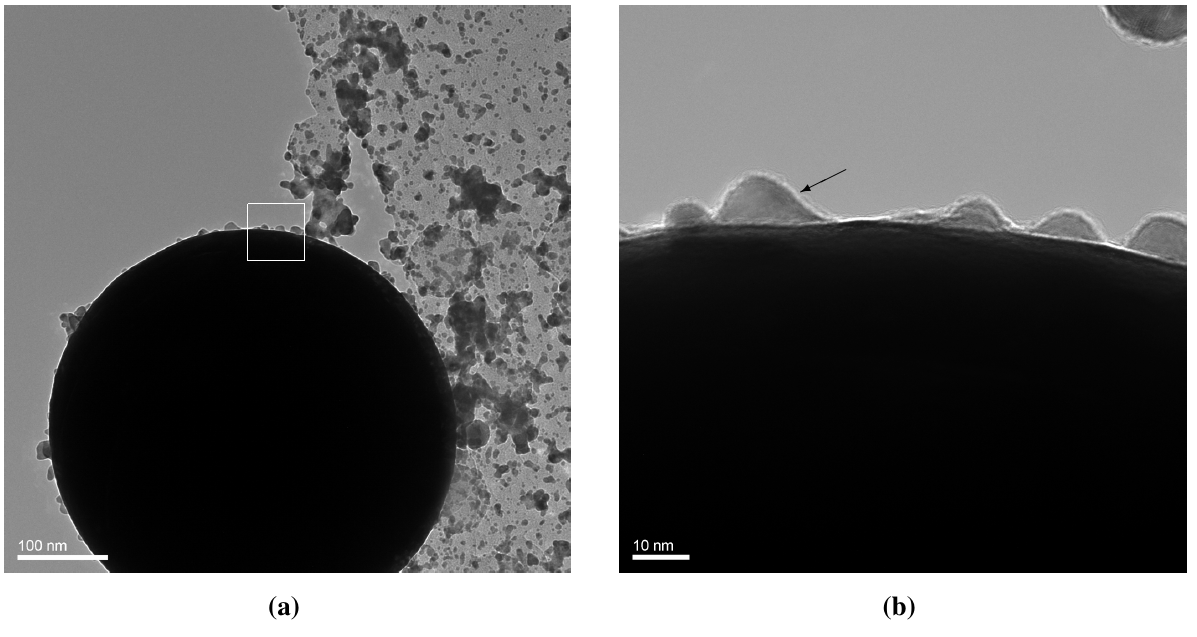
Figure 4. Au clusters deposited on an Au microsphere. ( a ) Au microsphere with Au clusters; ( b ) detail of the microsphere, with Au [111] lattice fringes indicated by the arrow. Scale bars are 100 nm and 10 nm,